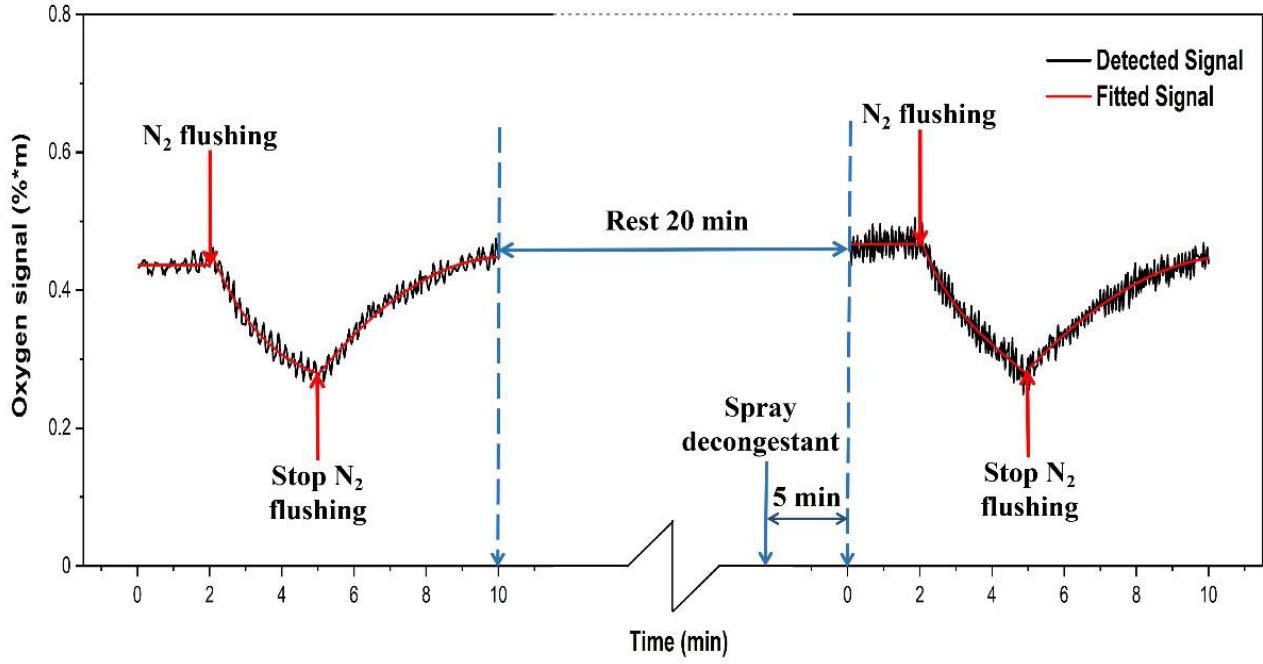
Figure 14. The measured O 2 signal from the left frontal sinus of the healthy volunteer. The dynamic of gas exchange, in the absence and presence of decongestant, is shown.